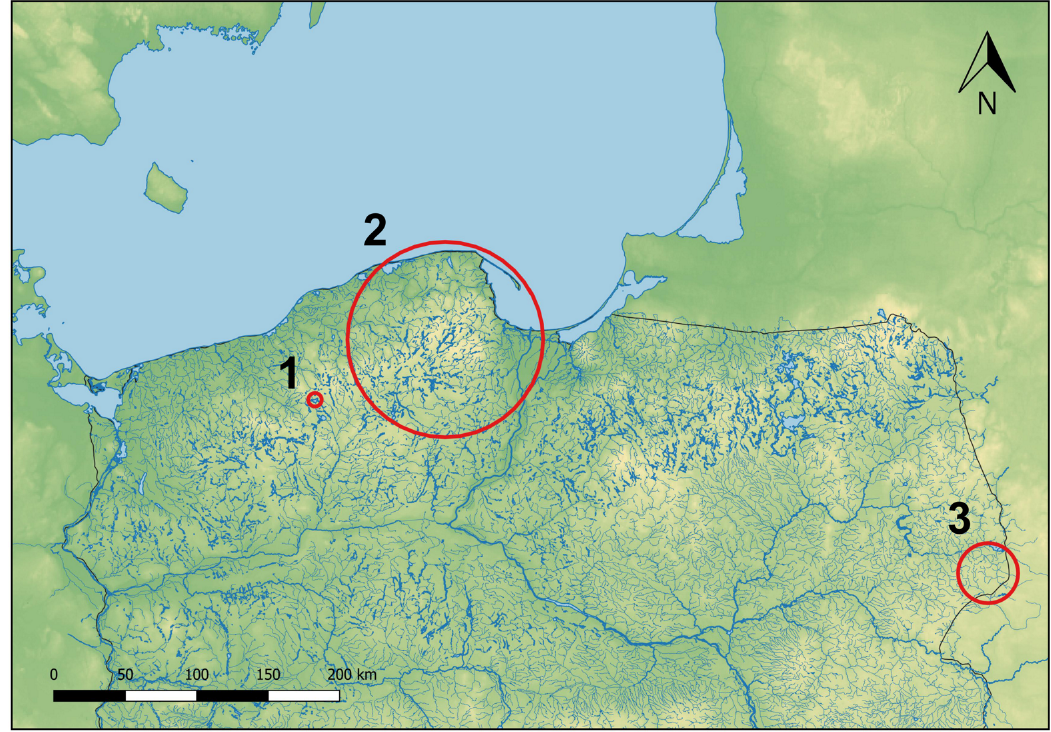
Figure 3. Research locations associated with the three case studies mentioned in the text: 1—Central Pomerania (Wierzchowo Lake micro-region); 2—Eastern Pomerania; 3—The Białowie˙za